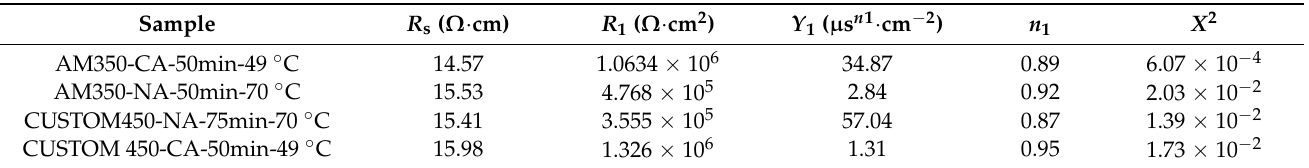
Table 7. EIS parameters obtained by EEC simulation of CUSTOM 450 and AM 350 passivated stainless steels immersed to 1 wt. % H 2 SO 4